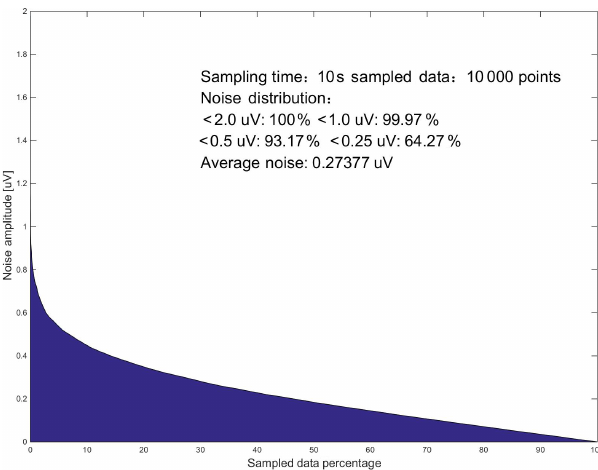
Figure 10. Distribution of the EIN of a data acquisition station.